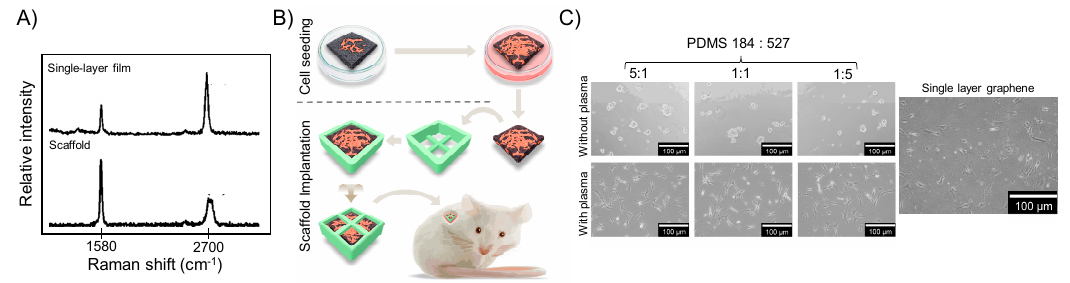
Figure 7. ( A ) Raman characterization. The Raman fingerprints confirmed the successful production of single layer graphene films and multilayer graphene scaffolds. ( B ) Graphene scaffold transplantation in vivo. MSC were seeded in the chemical vapor deposition (CVD)-grown graphene scaffolds (10 × 10 × 1 mm) and maintained in suspension plates at 37 °C for seven days to allow for attachment and proliferation. The scaffolds were placed in three-dimensionally (3D)-printed polylactide protection containers and implanted subcutaneously into immunodeficient mice for four weeks. ( C ) Cell attachment on PDMS with tunable elastic properties and graphene. Cells attached and proliferated on the surface of the oxygen plasma-etched PDMS substrates and single layer CVD-grown graphene.